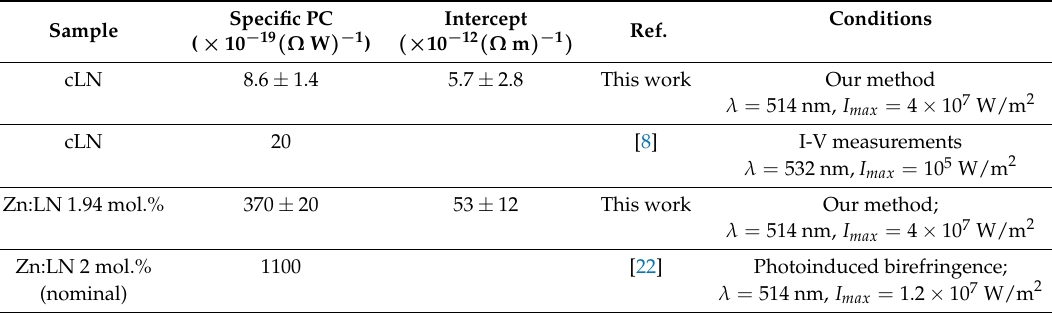
Table 1. Specific PC values obtained in samples cLN and